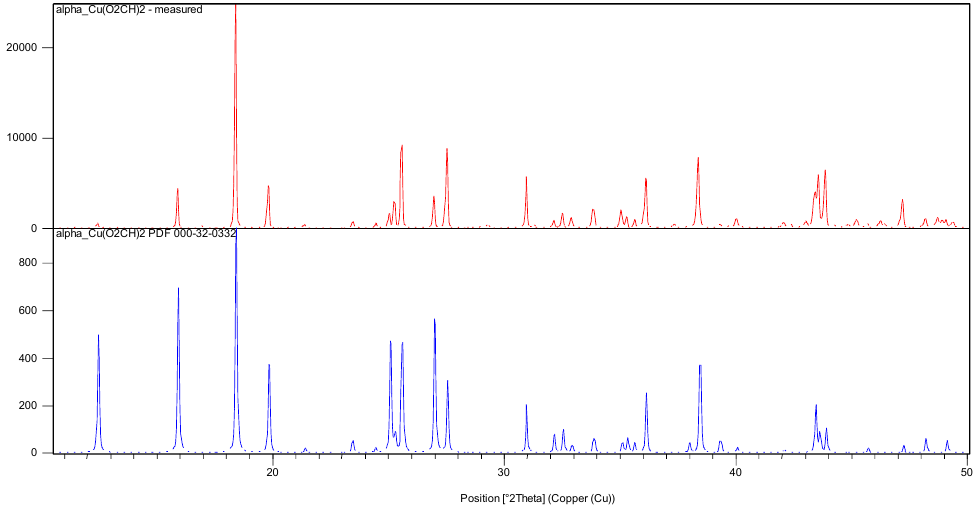
Fig. S1. X-Ray powder pattern of α -Cu(O blue curve = obtained from PDF-2 database, PDF no. 000-32-0332). Results of elemental analysis: Calc. for C